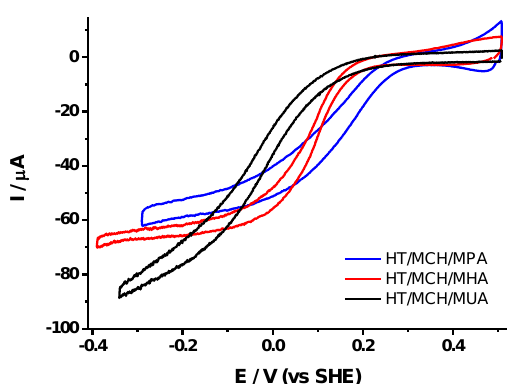
Figure 3. Voltammograms obtained for cytochrome bd oxidase with 2.5% added PE on gold NPs modified with HT / MCH / MPA (1 / 1 / 1) (blue trace), HT / MCH / MHA (1 / 1 / 1) (red trace) and HT / MCH / MUA (1 / 1 / 1) (black trace).